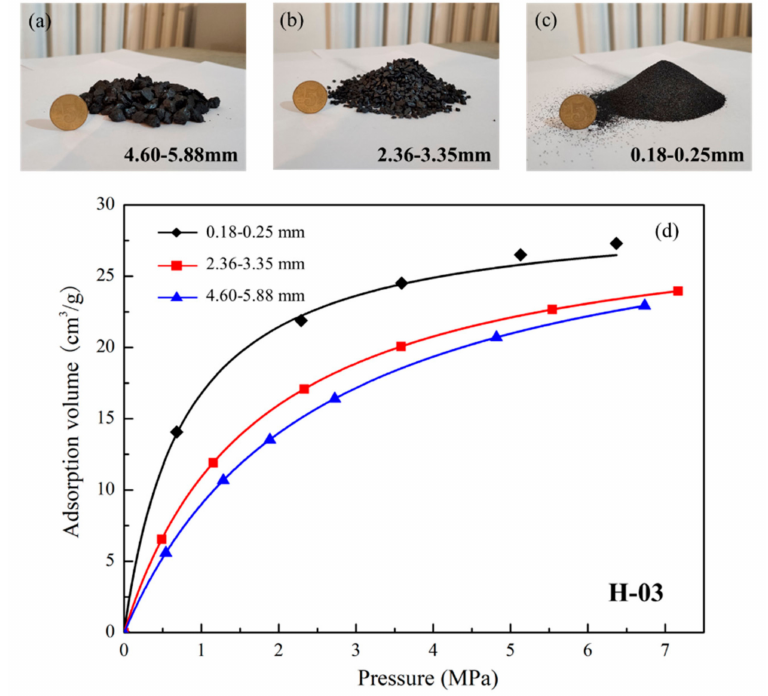
Figure 13. H-03 coal samples for adsorption experiment and isothermal adsorption curves. ( a ) Sample with particle size of 4.60–5.88 mm; ( b ) Sample with particle size of 2.36–3.35 mm; ( c ) Sample with particle size of 0.18–0.25 mm; ( d ) Isotherm adsorption curves of di ff erent particle size samples.